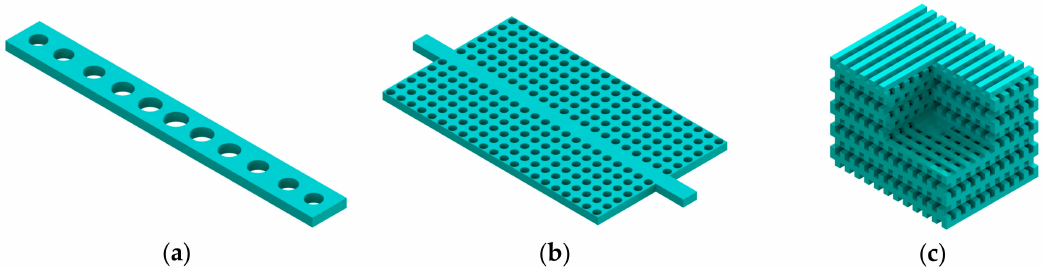
Figure 2. Schematic diagrams of cavities using ( a ) 1D, ( b ) 2D, and ( c ) 3D photonic crystals